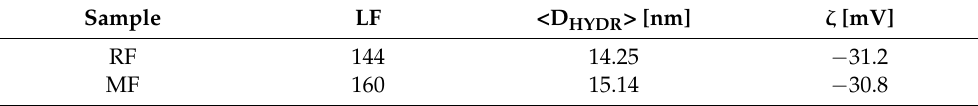
Table 1. Loading factor, hydrodynamic diameter, and zeta potential of ferritin